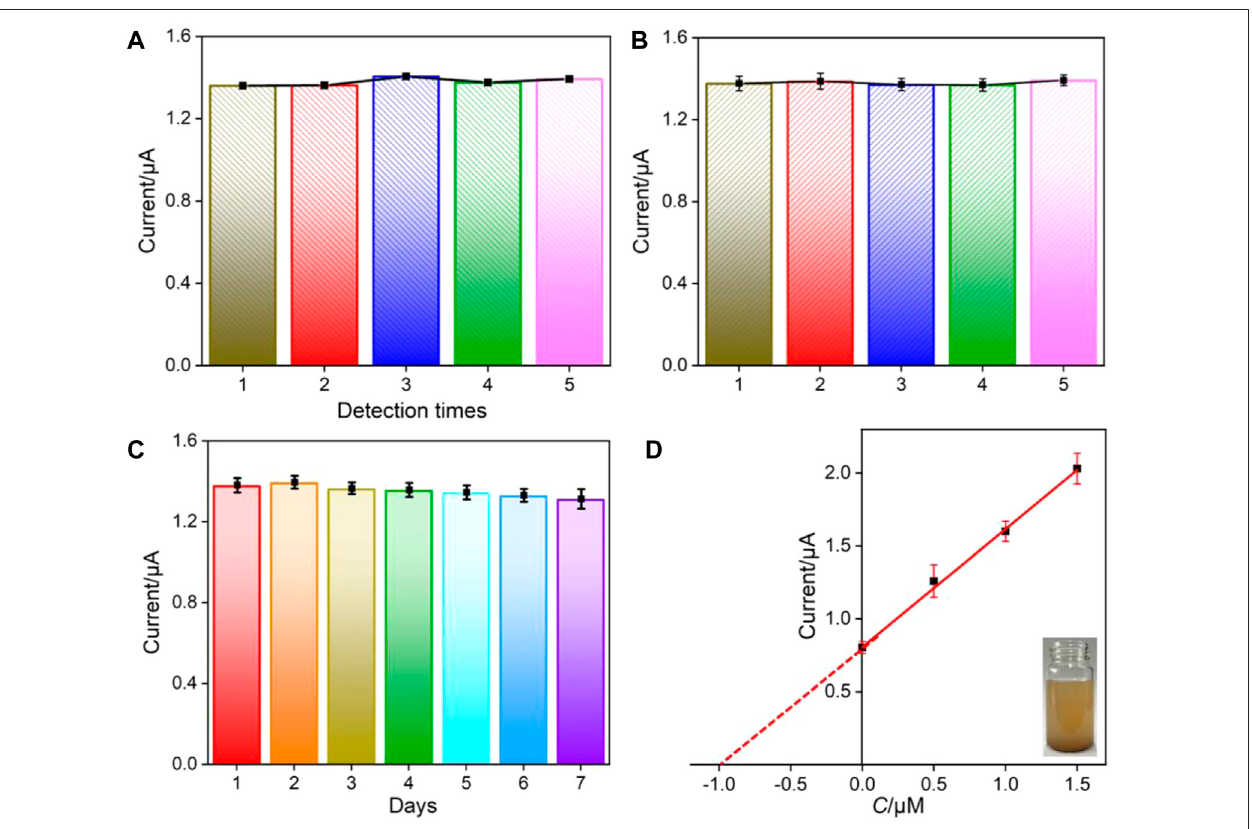
FIGURE 6 | Repeatability (A) , reproducibility (B) , and stability (C) of VMSF/p-GCE for the detection of BPA (1.0 μ M). (D) Linear relationship of the DPV current vs . the concentration of spiked BPAin SLS. Inset isthe digital picture of the detected SLS. The error bars representthe standard deviation (SD) of the three measurements.